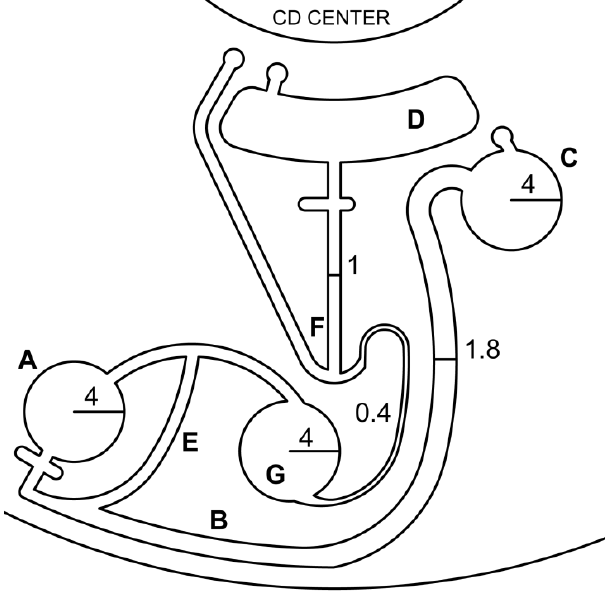
Figure 3. Schematic of gas-liquid pump design; dimensions are in millimeters. Liquid is pumped from the edge of the platform to a chamber closer to the center of the platform. (A) Sample Chamber; (B) Transfer Channel; (C) Final Chamber; (D) Reservoir; (E) Pushing Channel; (F) U-Trap; (G) Displacement Chamber.